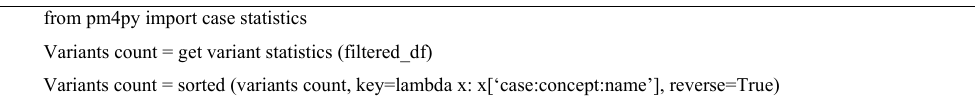
Algorithm 3. Grouping data based on variants